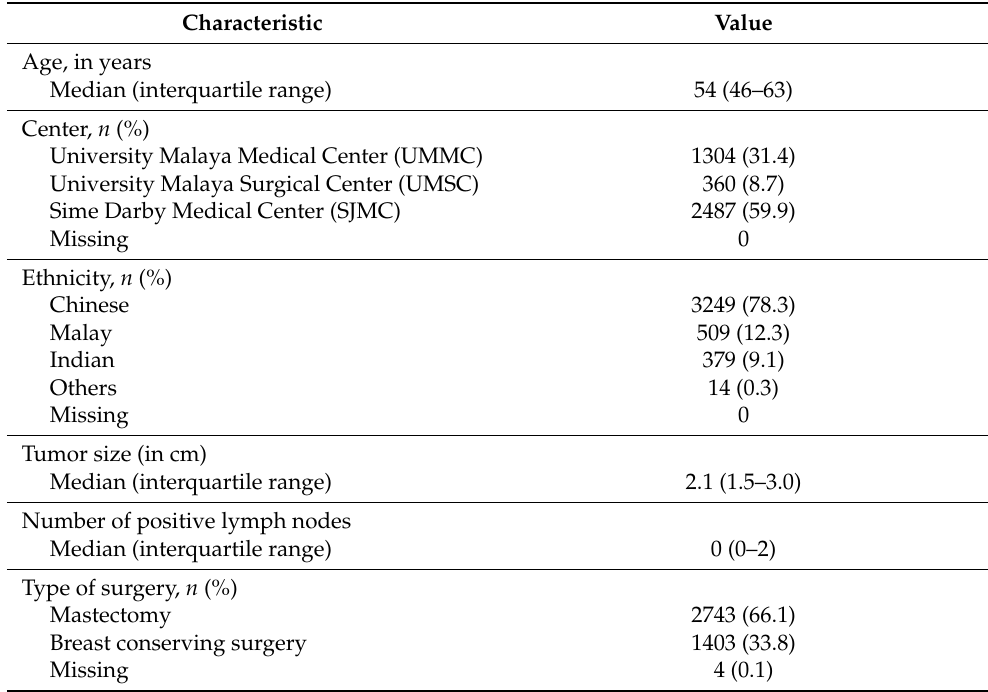
Table 1. Baseline characteristics of the study population ( n =